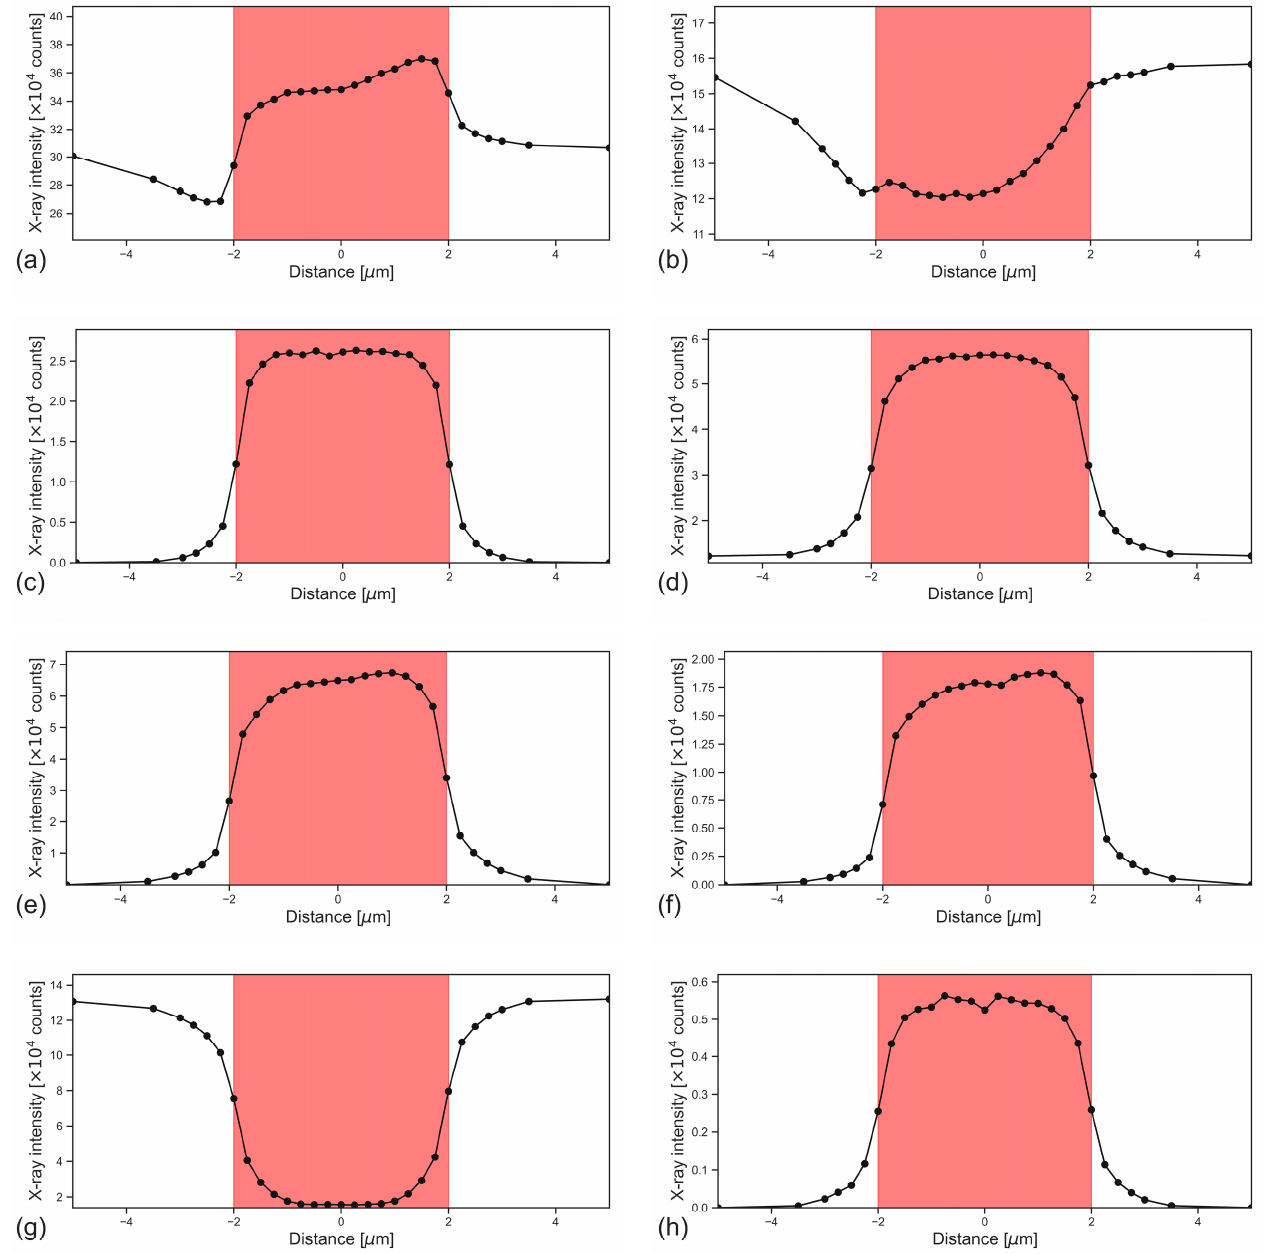
Figure 4. Integrated X-ray intensity calculated from simulated EDS spectra of the composite sample as a function of the distance of the analytical point from the centre of the circular section of the glass fibre (see Figure 1b). The red area in the various plots represents the fibre vertical section, with a radius of 2.0 µm. The reported trends are those calculated for the K α X-ray emission line of ( a ) Si, ( b ) Al, ( c ) Fe, ( d ) Ca, ( e ) Mg, ( f ) Na, ( g ) K and ( h ) Ti.